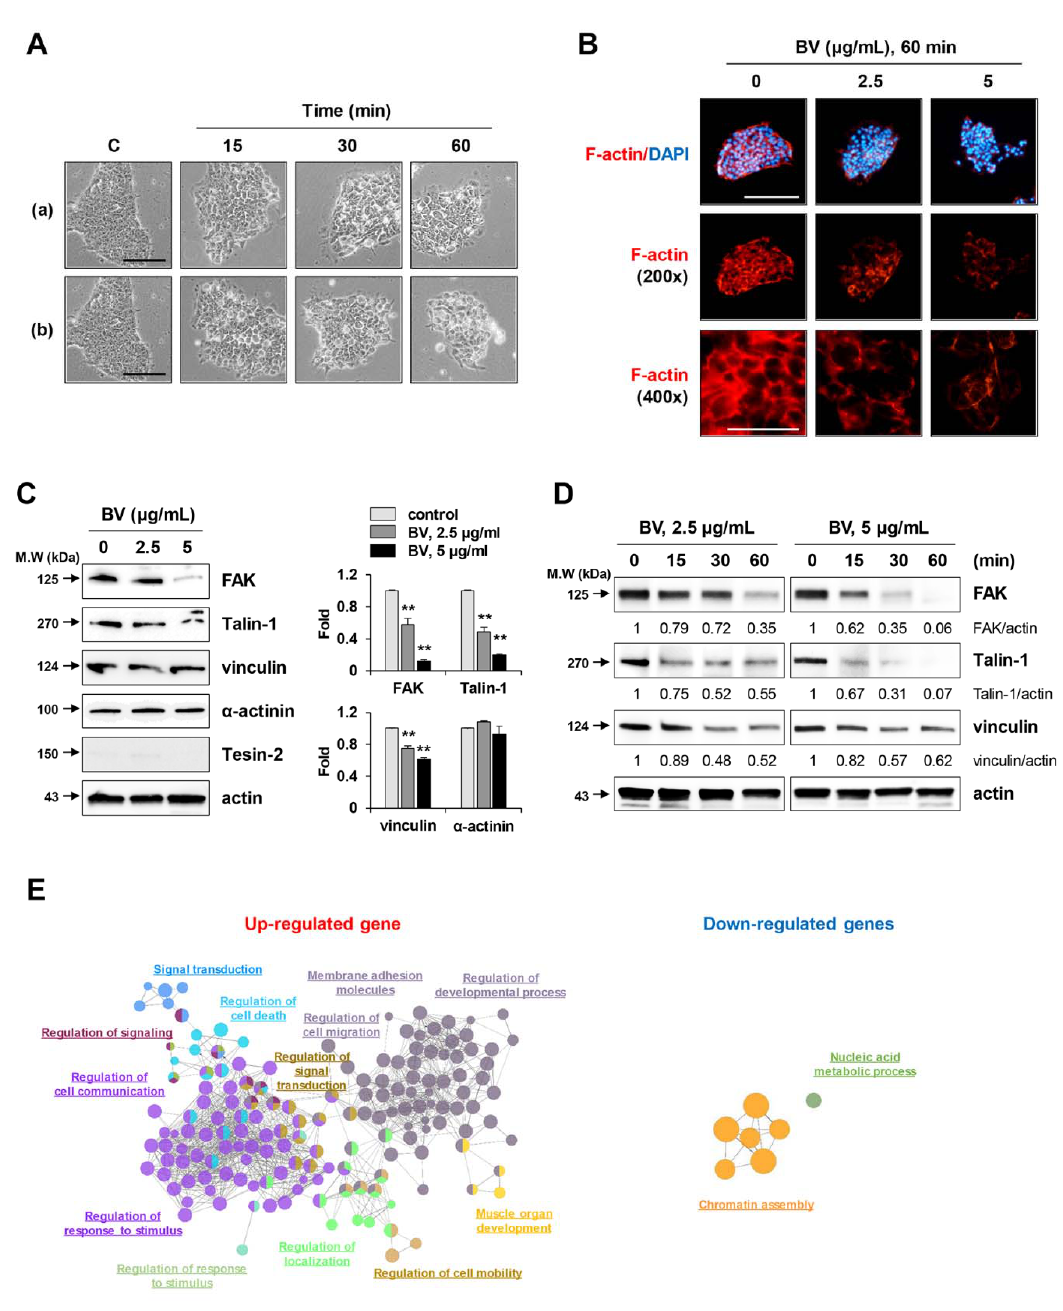
Figure 2. E ff ects of BV on the morphological change and F-actin intensity in iPSCs. ( A ) iPSCs were treated with 2.5 µ g / mL (a) and 5 µ g / mL (b) of BV and the morphological changes at 15, 30, and 60 min post-treatment were observed under an inverted microscope. Scale bar = 50 µ m. ( B ) iPSCs seeded on the confocal dishes were treated with 2.5 and 5 µ g / mL BV for 60 min and stained for F-actin with TRITC-conjugated phalloidin. Nuclei were counterstained with DAPI and then observed under a fluorescence microscope at low (200 × ) and high (400 × ) magnification. Scale bar = 50 µ m. ( C ) iPSCs were treated with 2.5 and 5 µ g / mL BV for 1 h and the levels of focal adhesion proteins were determined by Western blotting. Relative band intensities compared with BV-untreated iPSCs were calculated using Image J software after normalization to actin expression and expressed as means ± SD from two independent samples. ** p < 0.01 vs. BV-untreated control ( D ) iPSCs were treated with 2.5 and 5 µ g / mL BV. Protein samples at 15, 30, and 60 min post-treatment were harvested and then subjected to